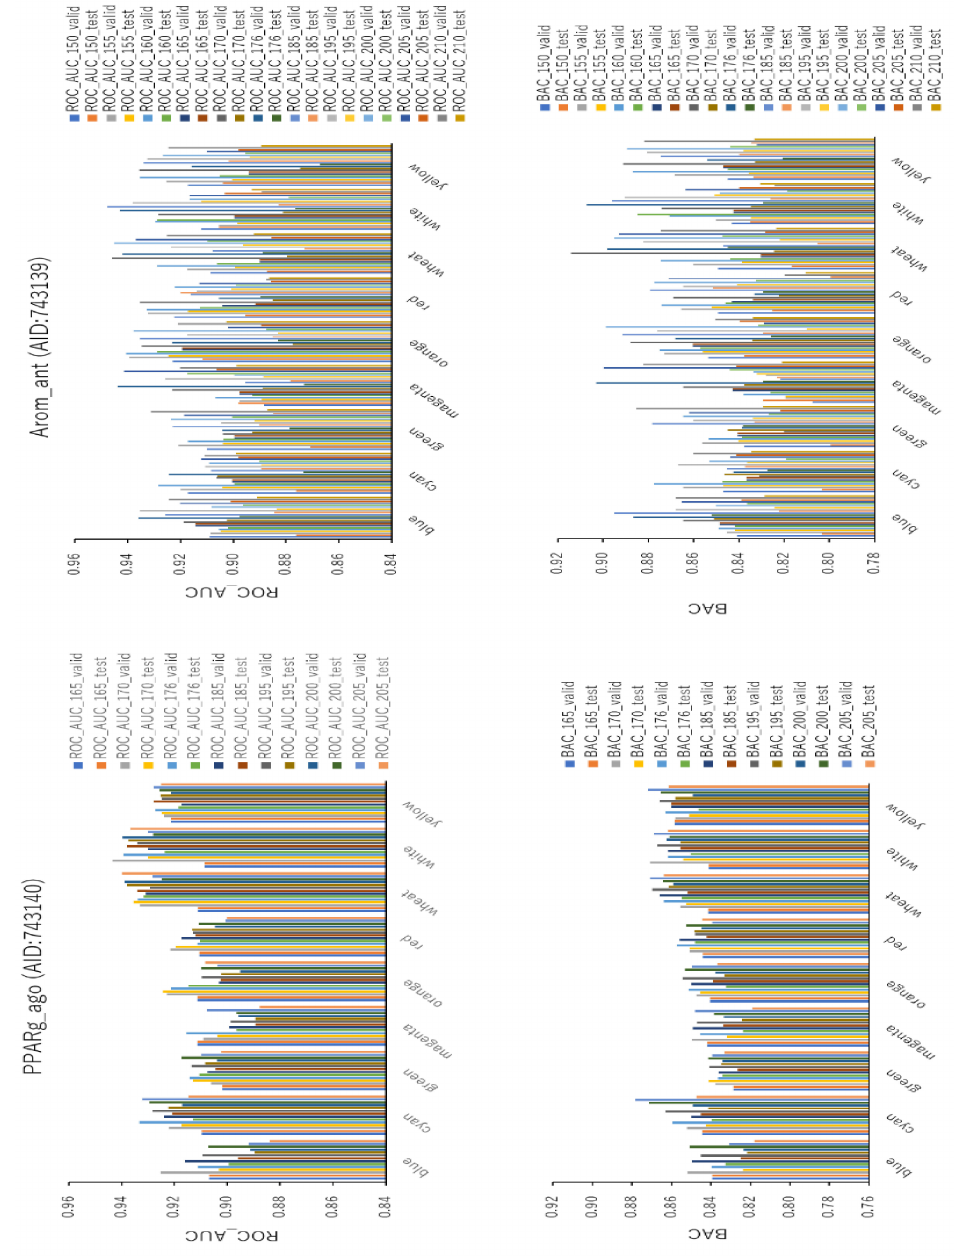
Figure 12. ROC_AUC and BAC for PPARg_ago (AID:743140) and Arom_ant (AID:743139) using TensorFlow with different background colors. Three-fold experiments were